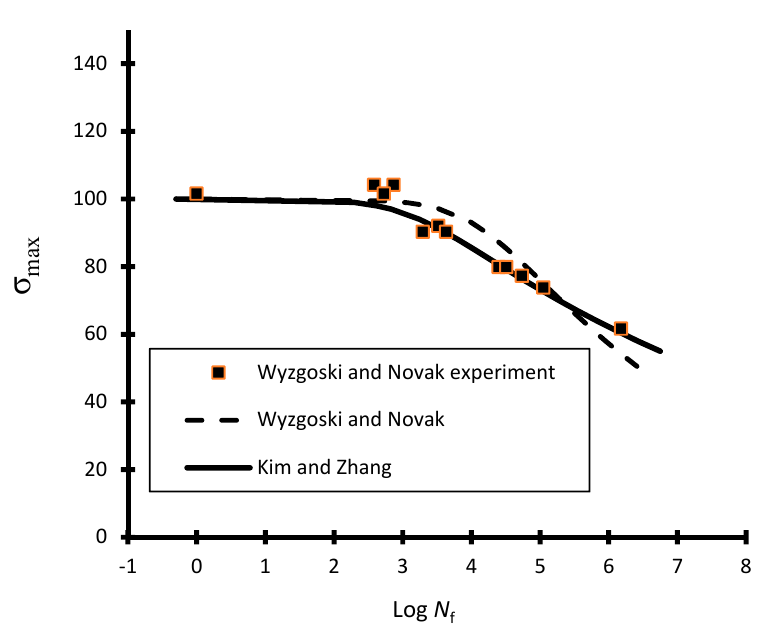
Figure 4. Wyzgoski and Novak [71] experimental data and S-N curve according to Equation (38) with t = 0.0032 m, m = 7.41, A =1.53 × 10 − 10 m/cycle, Y = 1.17, R = 0.1, and a 0 = 0.354 mm. Another S-N curve was plotted according to the Kim and Zhang model Equation (23) with α = 1.53 × 10 − 10 and α = 15.028.